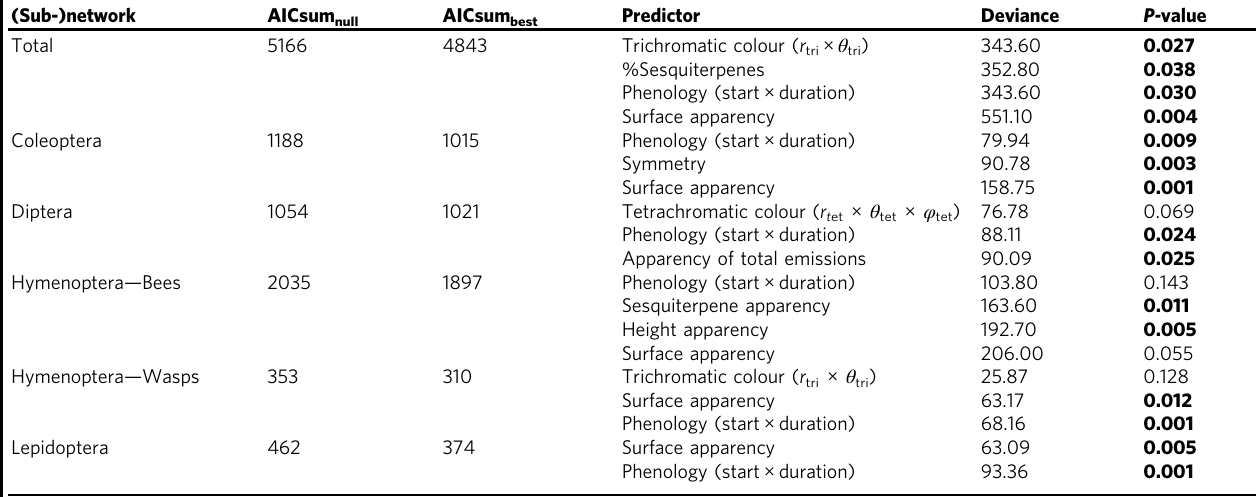
Table 2 Floral traits associated with the quantitative distribution of links in the static network and its sub-networks